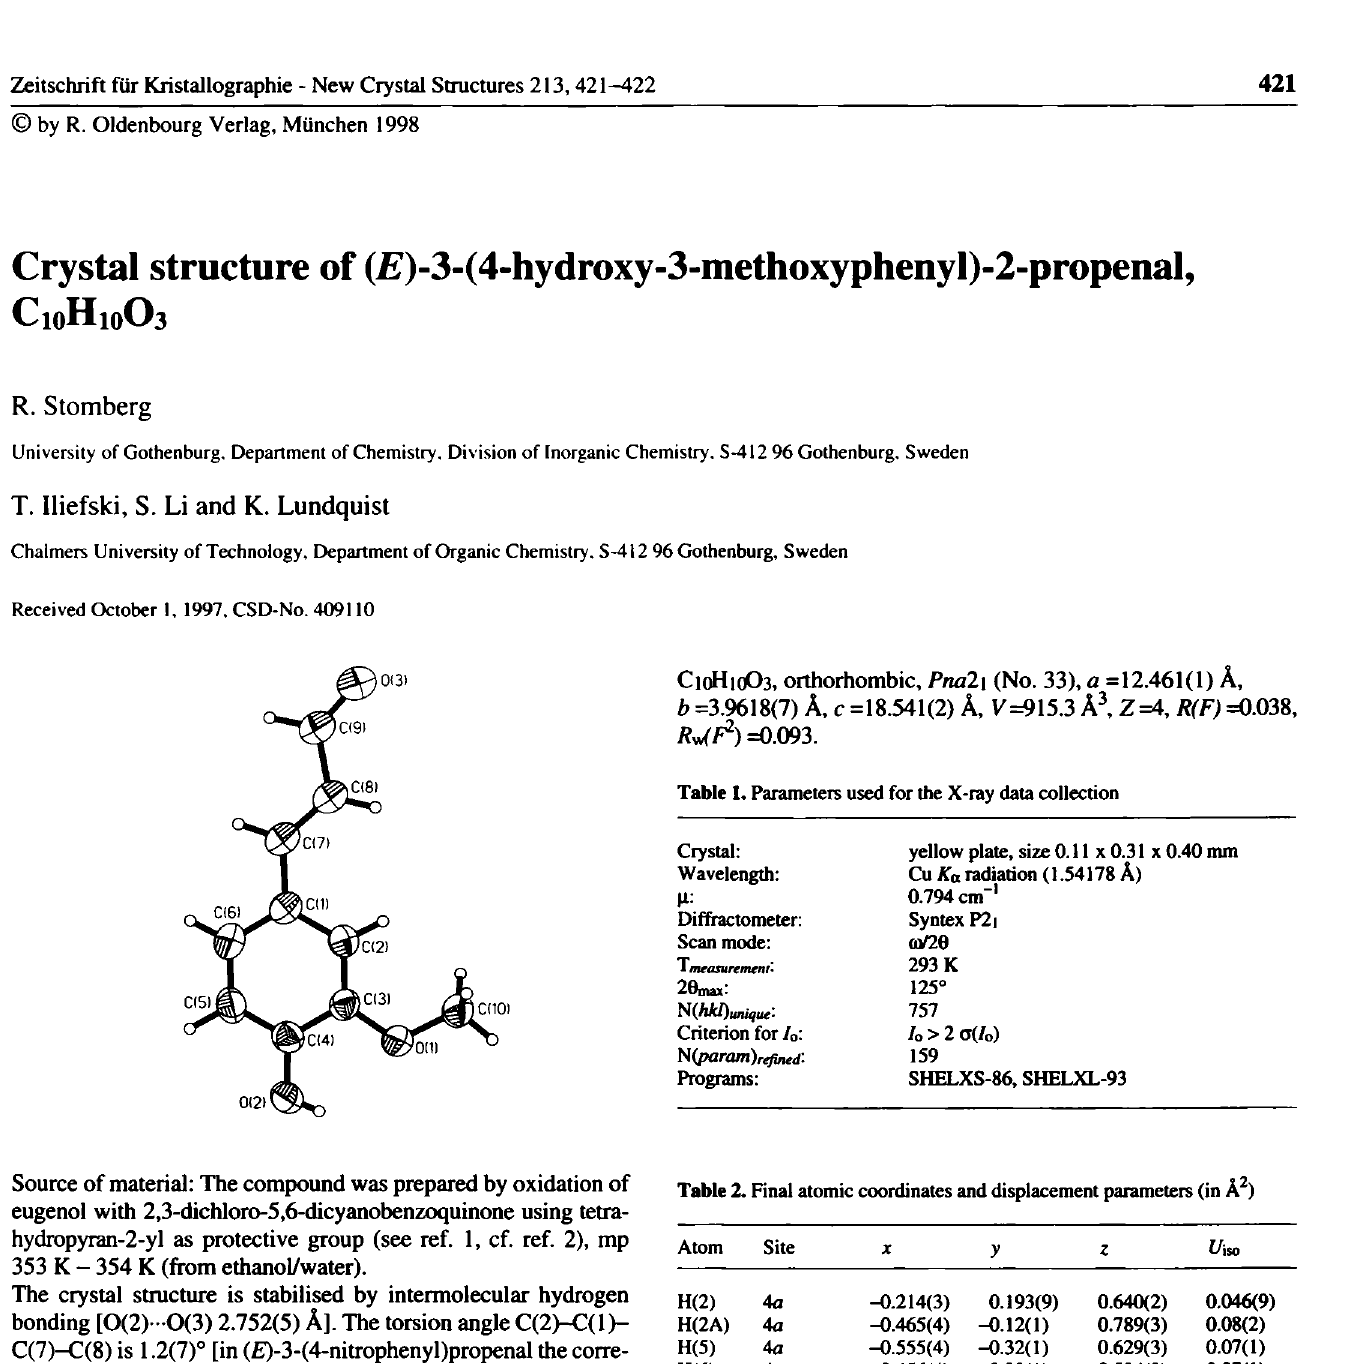
Table 3. Final atomic coordinates and displacement parameters (in Â^)